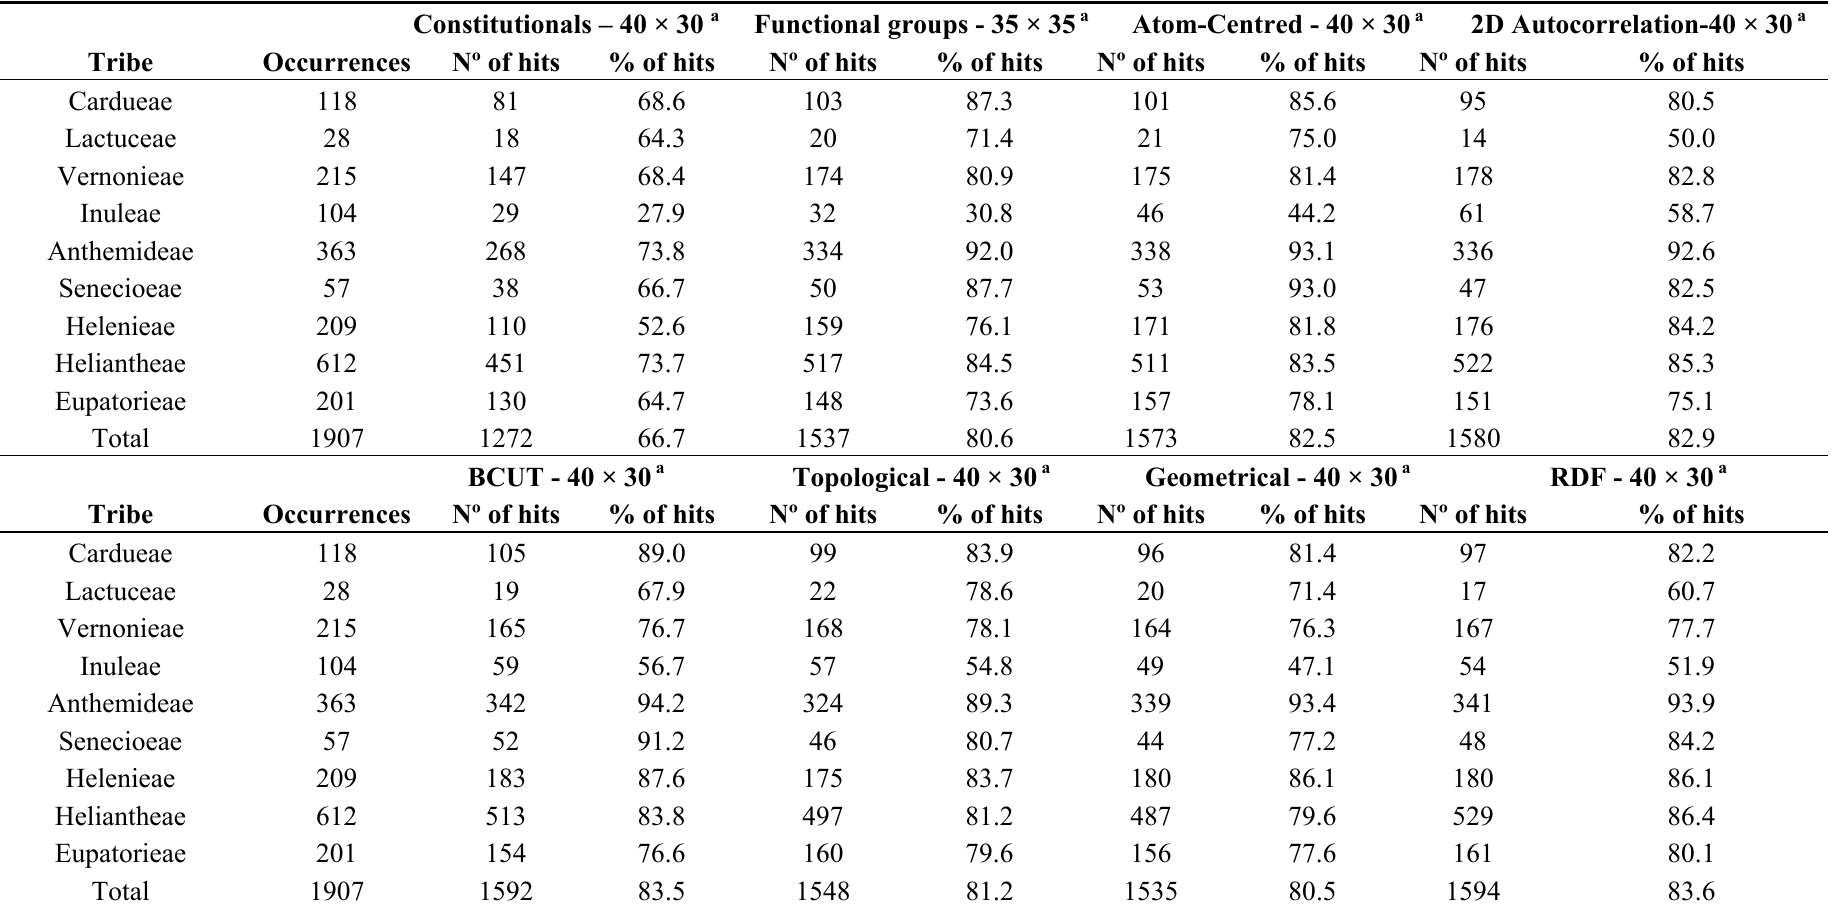
Table 3. Results of the self-organising maps and their respective dimensions, with the values of the occurrences and the number of absolute and relative hits for the nine tribes of the Asteraceae family, using the blocks of descriptors that were generated by the DRAGON 6.0